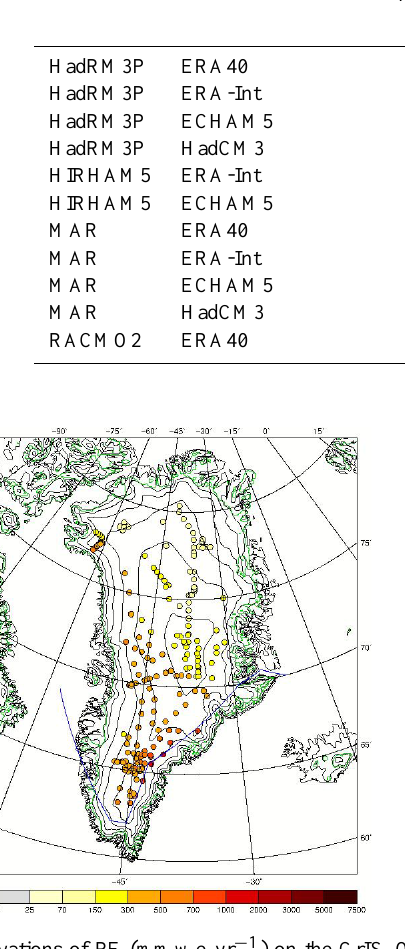
Fig. 7. Observations of PE (mmw.e.yr − 1 ) on the GrIS. Observa- tions from south of the blue line are excluded from the analysis as they lie outside the area for which the bias correction method is tuned. The green line represents the ice sheet margin in RACMO2.